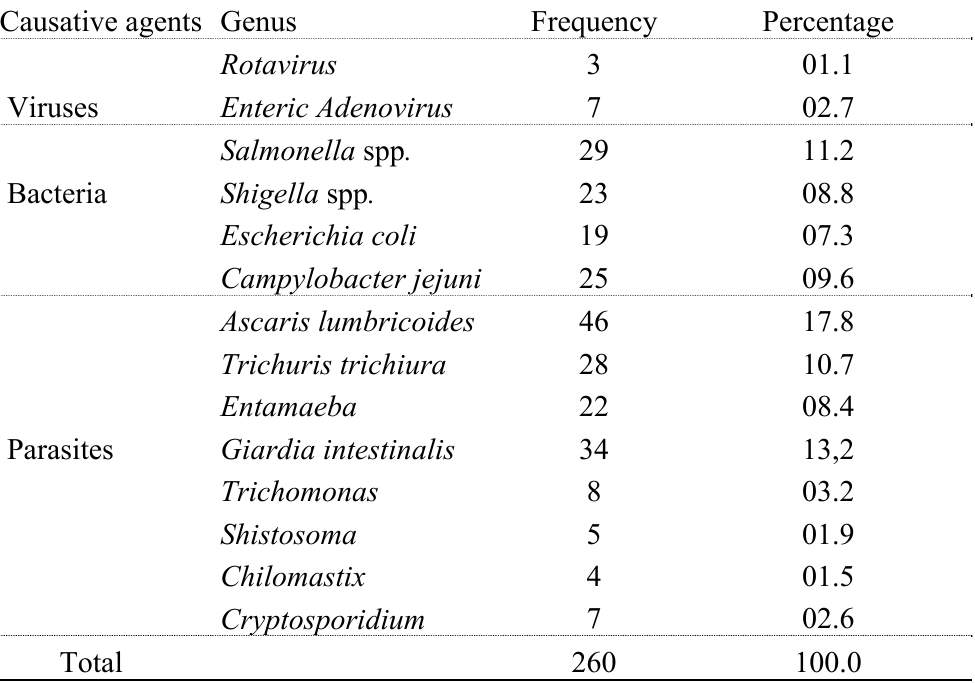
Table 3. Infectious agents identified in diarrheic